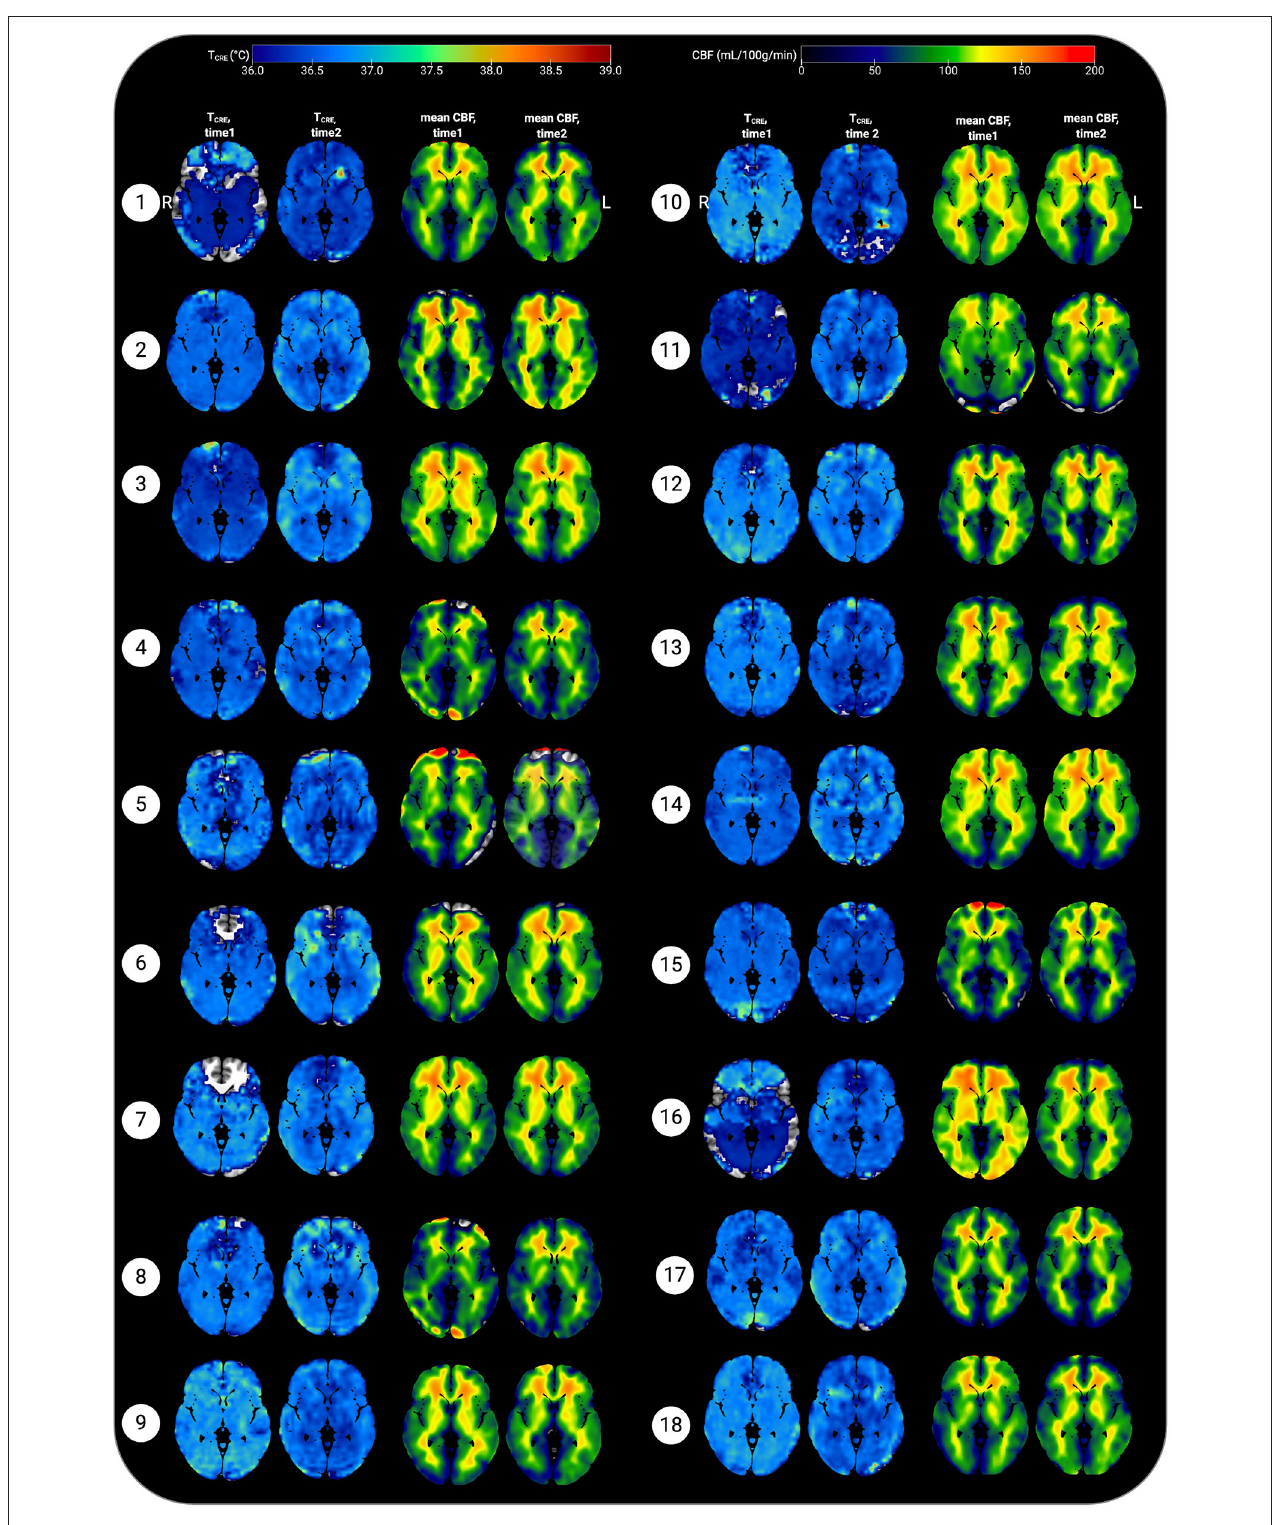
FIGURE 5 | Representative axial slices showing brain temperature (T CRE ) and cerebral blood flow (CBF) for 18 healthy participants at time 1 and time 2. Brain temperature was non-invasively measured using volumetric magnetic resonance spectroscopic imaging (MRSI) data, with calculation according to the following equation: T CRE = − 102.61( 1 H20 − CRE ) + 206.1 ◦ C, 1 H20 − CRE = chemical shift difference between the creatine and water resonances. Mean CBF maps (ml/100 g/min) were generated following processing of arterial spin labeling (ASL) data, with voxel-level CBF quantified using simple subtraction between each tag/control pair